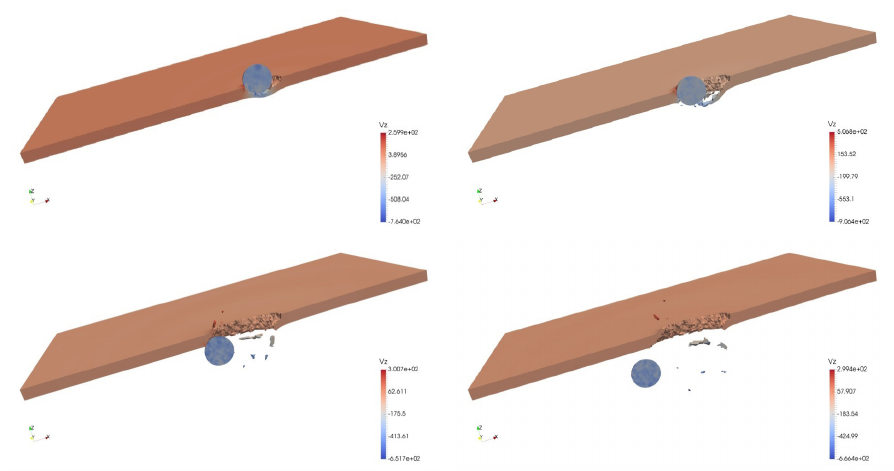
Figure 3. Calculated configurations of projectile and barrier